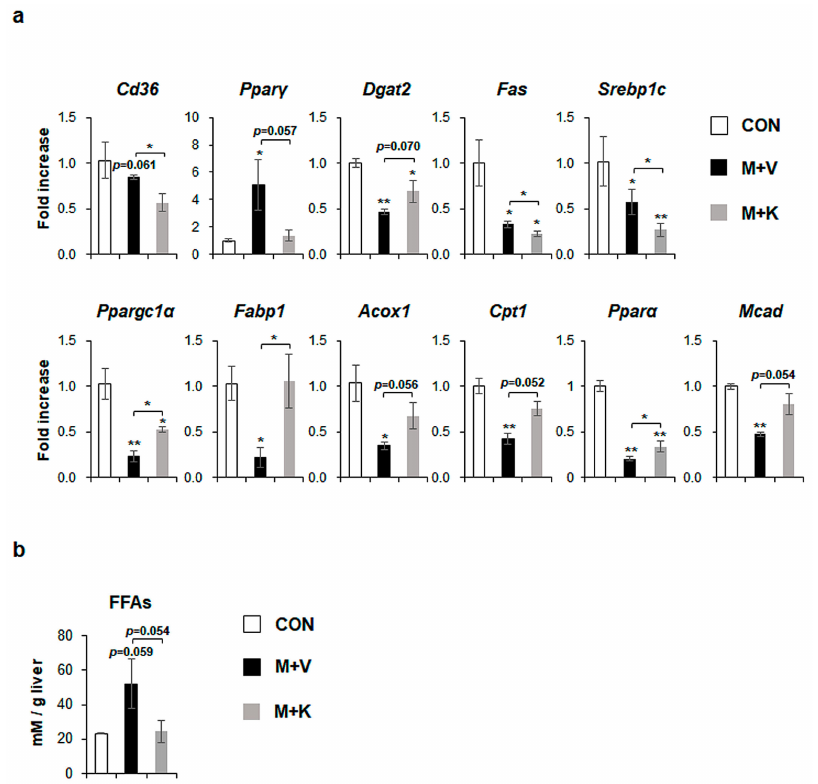
Figure 4. KT treatment improves hepatic lipid metabolism in MCD-fed db / db mice ( a ) qRT-PCR analysis for cluster of di ff erentiation 36 (Cd36), peroxisome proliferator-activated receptor gamma (Ppar γ ), Diacylglycerol- O -acyltransferase 2 (Dgat2), fatty acid synthase (Fas), sterol regulatory element binding protein 1c (Srebp1c), peroxisome proliferator-activated receptor gamma coactivator 1 alpha (Ppargc1 α ), fatty acid binding protein (Fabp1), acyl coenzyme A oxidase 1 (Acox1), carnitine palmitoyltransferase 1 (Cpt1), peroxisome proliferator-activated receptor alpha (Ppar α ), and medium-chain-acyl-coenzyme A dehydrogenase (Mcad) in livers of the experimental animals. Results were described as fold increase. ( b ) Hepatic level of free fatty acids in these mice. All of the results are display as mean ± SEM ( n ≥ 3 / group, * p < 0.05, ** p < 0.005 vs. control